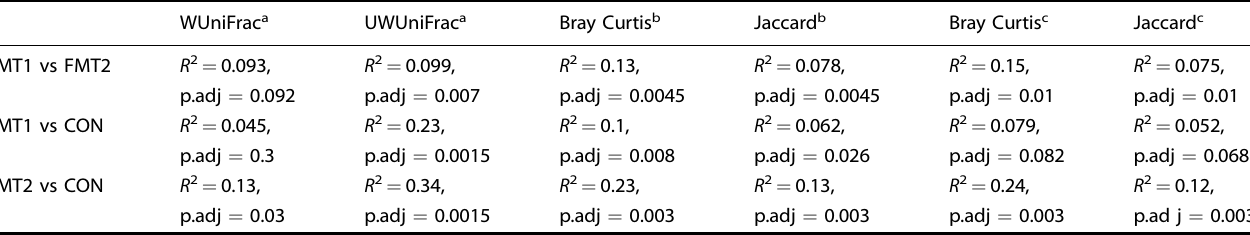
Table 1. Pairwise PERMANOVA between recipient groups on dissimilarity metrics.